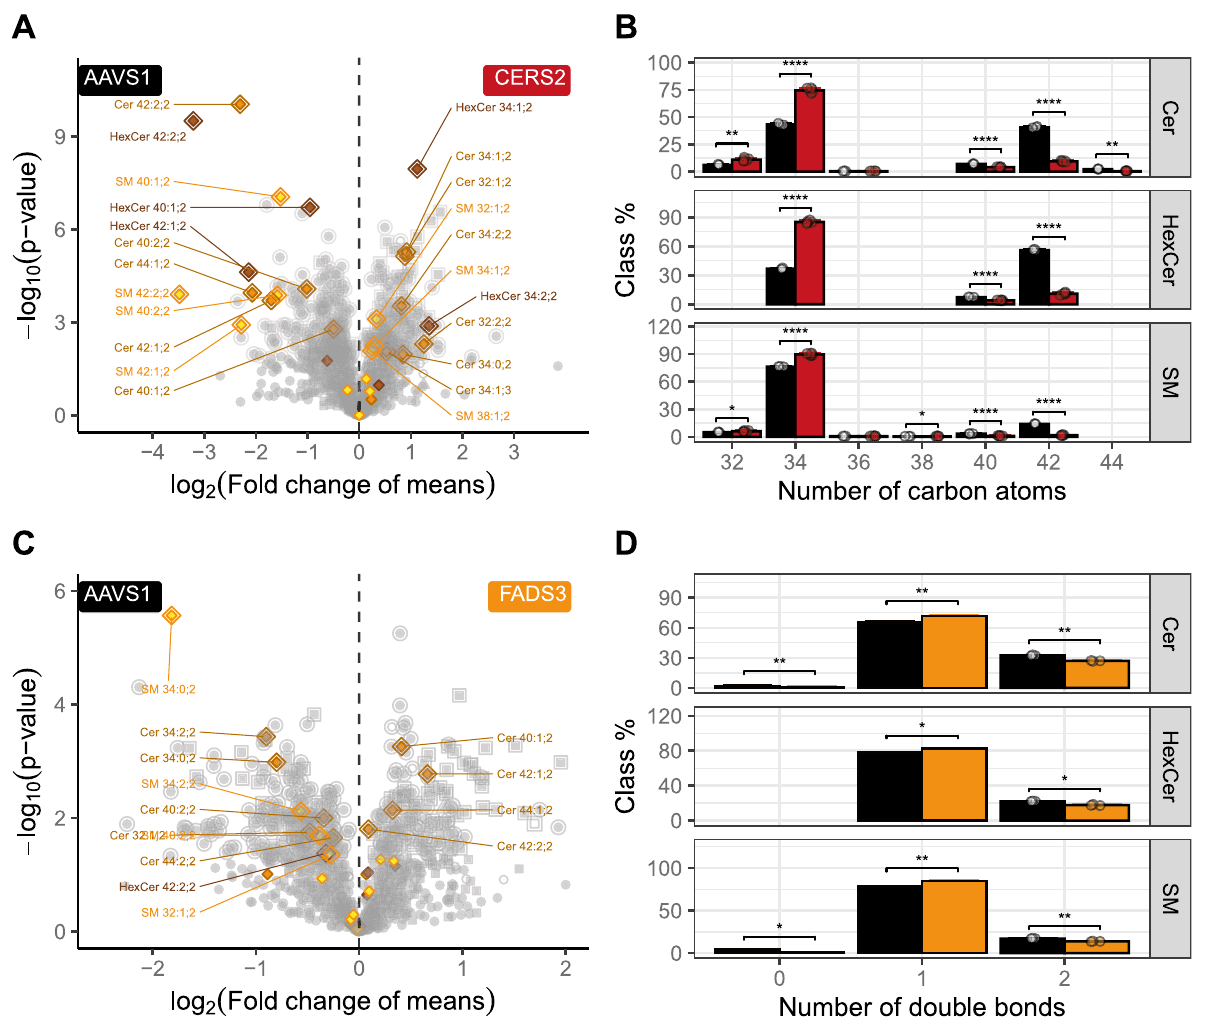
Figure 3. CERS2 and FADS3 Knockouts: ( A ) CERS2 KO Volcano plot: Lipid species of the CERS2 KO cell line (n = 6) and the AAVS1 control (n = 3) were compared. P-values of t-test without correction for multiple testing are displayed on the y-axis, fold changes of means are shown on the x-axis. Points with additional outlines indicate lipids significant after correction for multiple testing (Benjamini–Hochberg, 365 lipid species or 29.7% of all species). Sphingolipid species are labeled by their species names. ( B ) CERS2 KO sphingolipid length distribution: Lipid species have been standardized to the lipid class and summed up by their total number of carbon atoms. Values for individual samples are shown by points and means are indicated by bar plots. Error bars correspond to standard deviations. P-values have been adjusted for the total number length features in all classes (n = 168) and are encoded as follows: * for q < 0.05, ** for q < 0.01, *** for q < 0.01,**** for q < 0.0001. Only lipid species were used, which had at least 2 valid measurements in each of the two cell lines (n = 1228). The CERS2 KO clones A10 and B11 are displayed, which were created by the deletion method. ( C ) FADS3 KO Volcano plot: Lipid species of the FADS3 KO cell line (n = 3) and the AAVS1 control (n = 3) were compared. P-values of t-test without correction for multiple testing are displayed on the y-axis, fold changes of means are shown on the x-axis. Points with additional outlines indicate nominal significant lipids (87 lipid species or 8.2% of all species). Sphingolipid species are labeled by their species names. ( D ) FADS3 KO sphingolipid double bond distribution: Lipid species have been standardized to the lipid class and summed up by their total number of double bonds. Values for individual samples are shown by points and means are indicated by bar plots. Error bars correspond to standard deviations. p-values have been adjusted for the total number db features in all classes (n = 113) and are encoded as follows: * for q < 0.05, ** for q < 0.01, *** for q < 0.01,**** for q < 0.0001. Only lipid species were used, which had at least 2 valid measurements in each of the two cell lines (n = 1064). The FADS3 KO clone C02 is displayed, which was created by the deletion